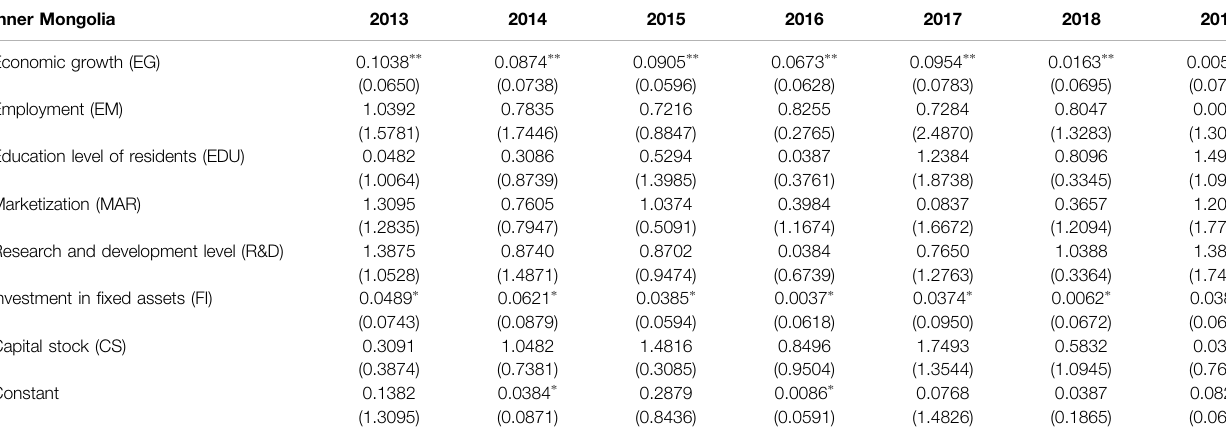
TABLE 20 | Driving force of Inner Mongolia health tourism industry